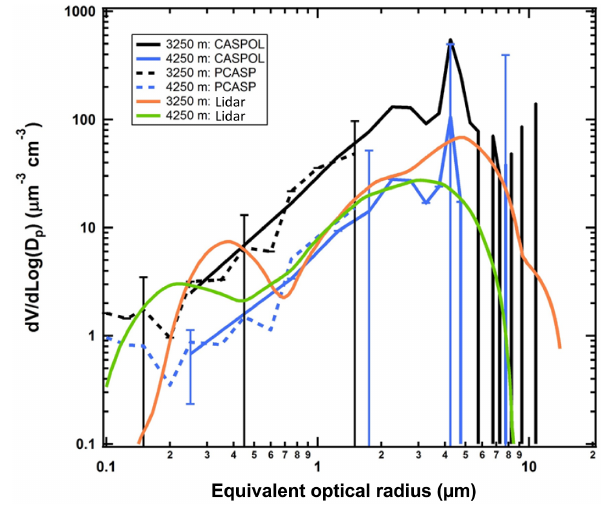
Figure 7. Size distributions of volume concentrations derived from the combined PCAP-100X and CAS-POL measurements and size distributions retrieved with the regularization technique from the lidar nighttime measurements at 3250 and